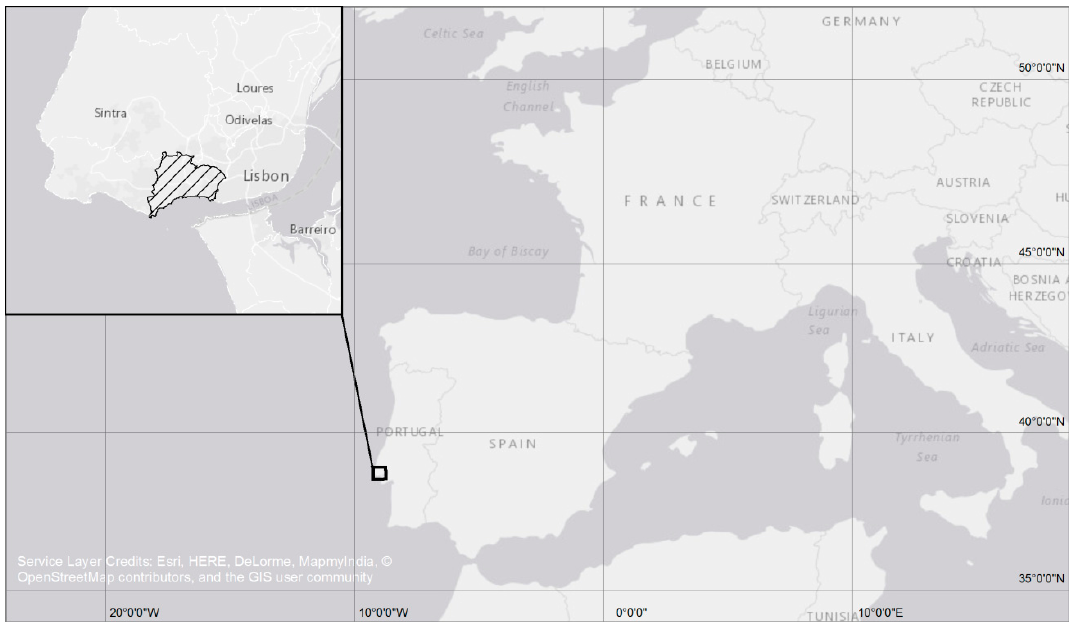
Figure 6. Case study location.